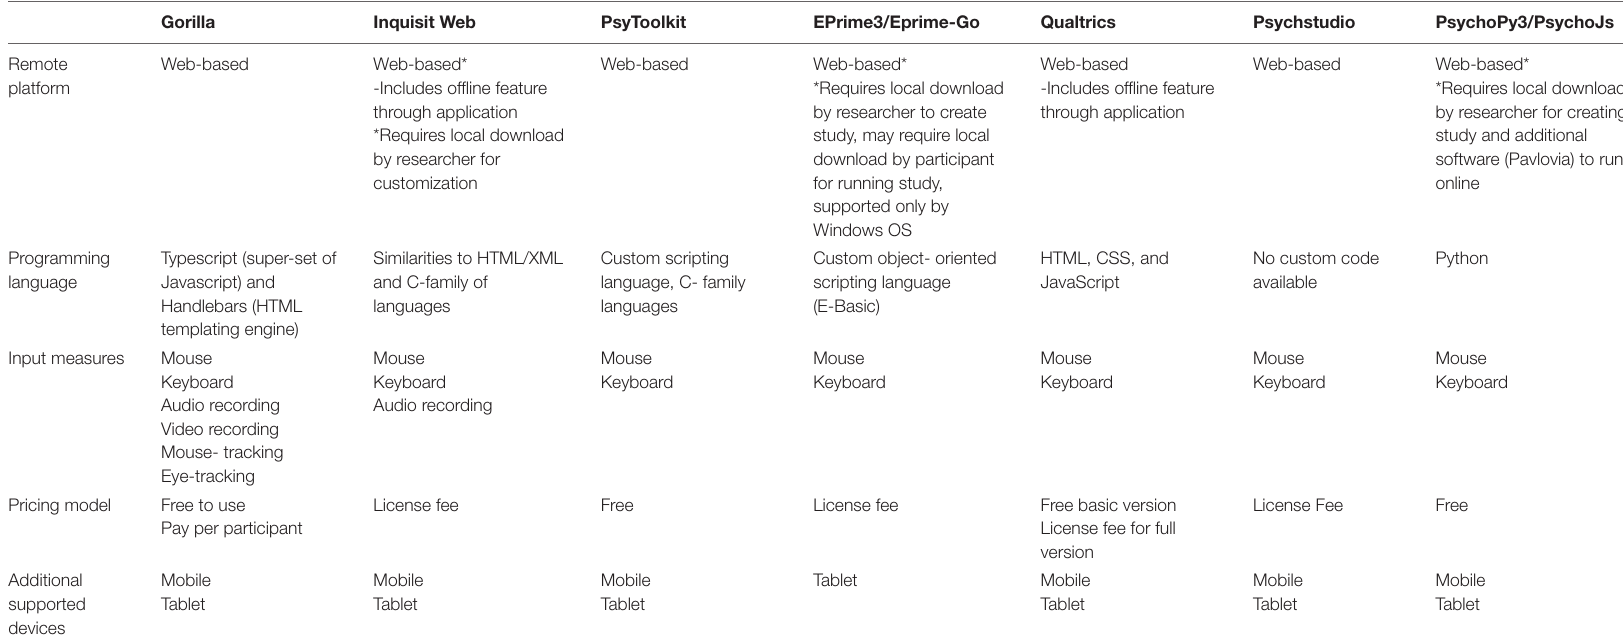
TABLE 1 | Comparison of remote